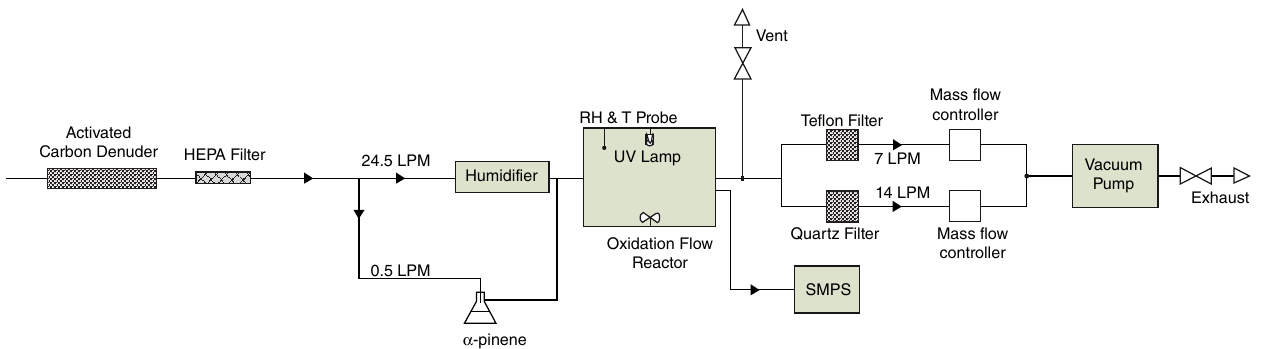
Figure 1. Biogenic ( α -pinene) particulate matter (PM) sampling setup.